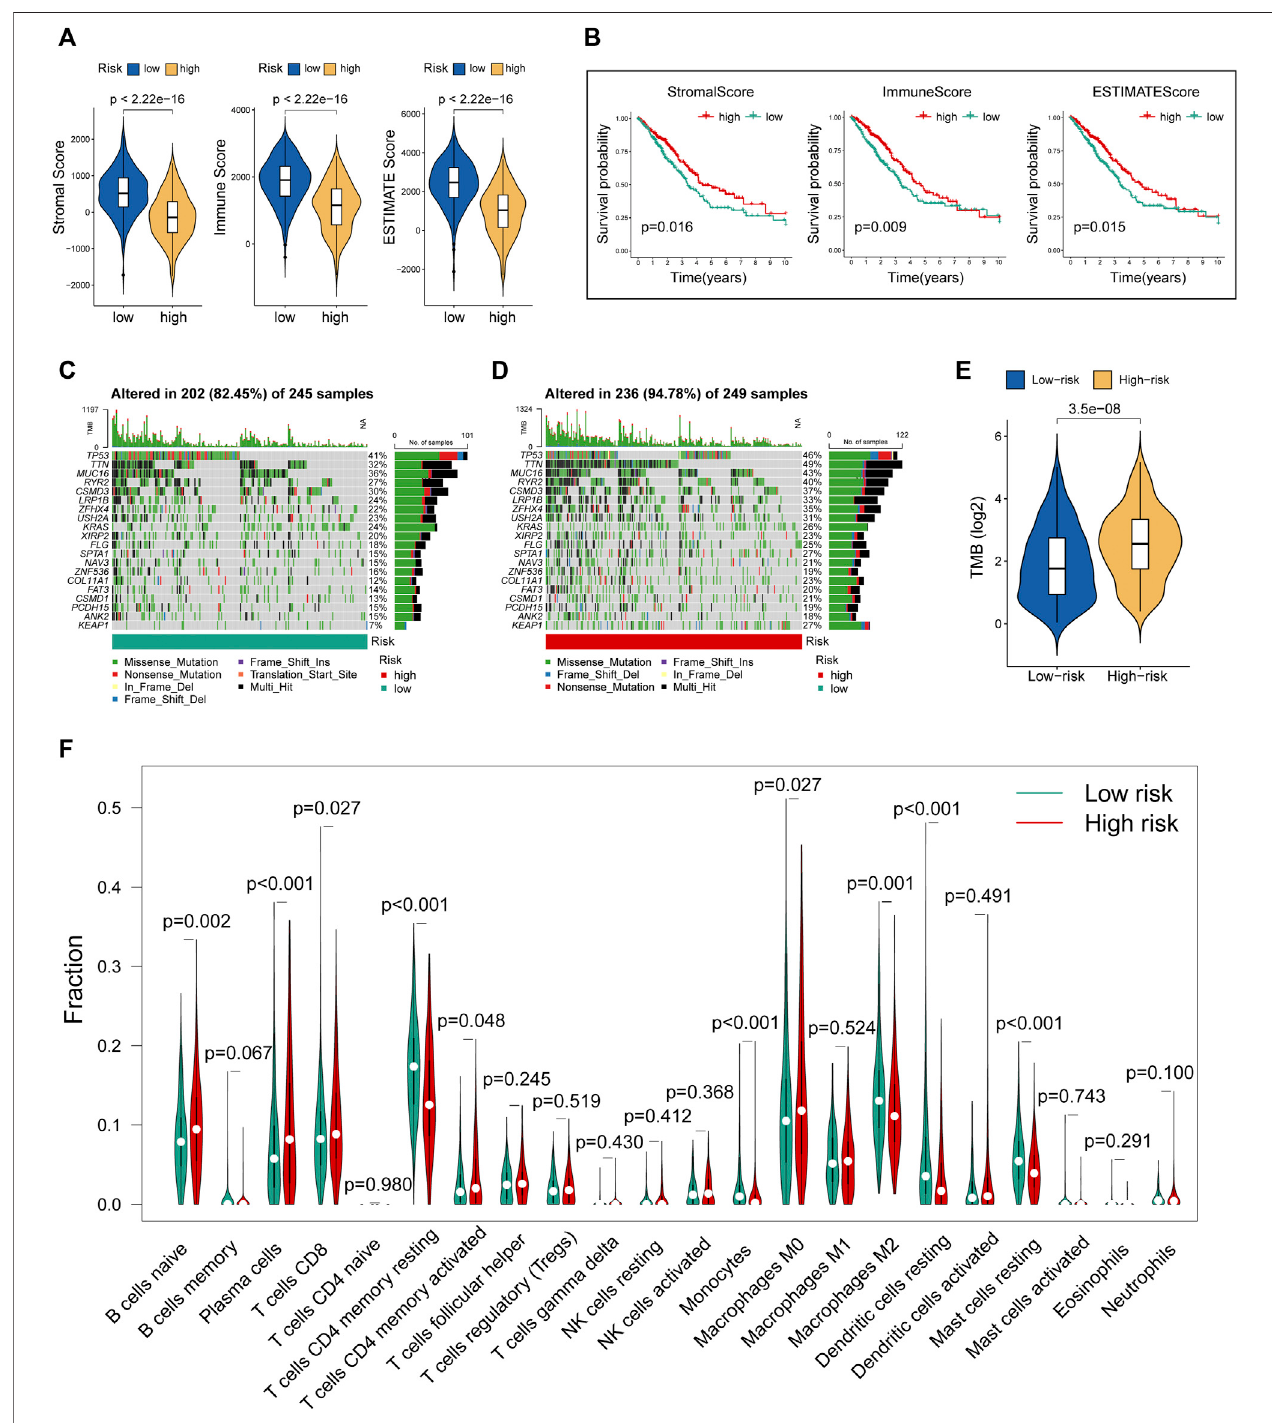
FIGURE 5 | Evaluation of tumor microenvironment, TMB, and immune cell in fi ltration between different risk groups. (A) The differences of stromal score, immune score, and ESTIMATE score between the low- and high-risk groups. (B) The survival differences between the LUAD subgroups classi fi ed by stromal score, immune score, and ESTIMATE score. (C) The mutationallandscape of the top 20 genes with the highest mutation frequency in the low-risk group. (D) The mutationallandscape of the top 20 genes with the highest mutation frequency in the high-risk group. (E) The differences of TMB score between the low- and high-risk groups. (F) Estimation of immune cell in fi ltration in LUAD patients using the CIBERSORT algorithm.